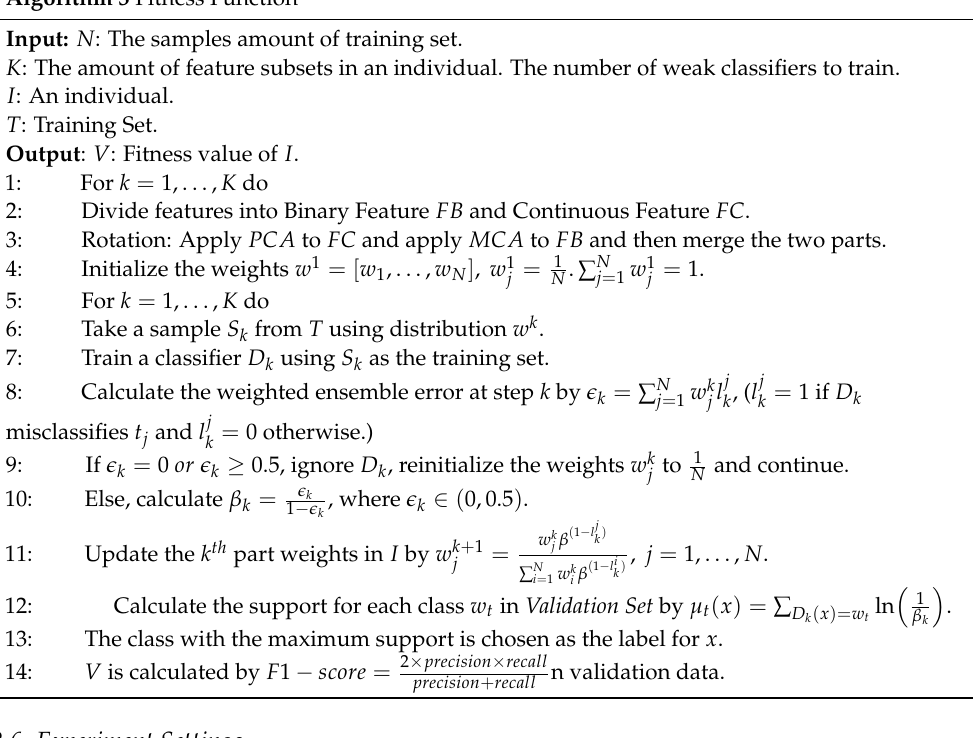
Algorithm 3 Fitness